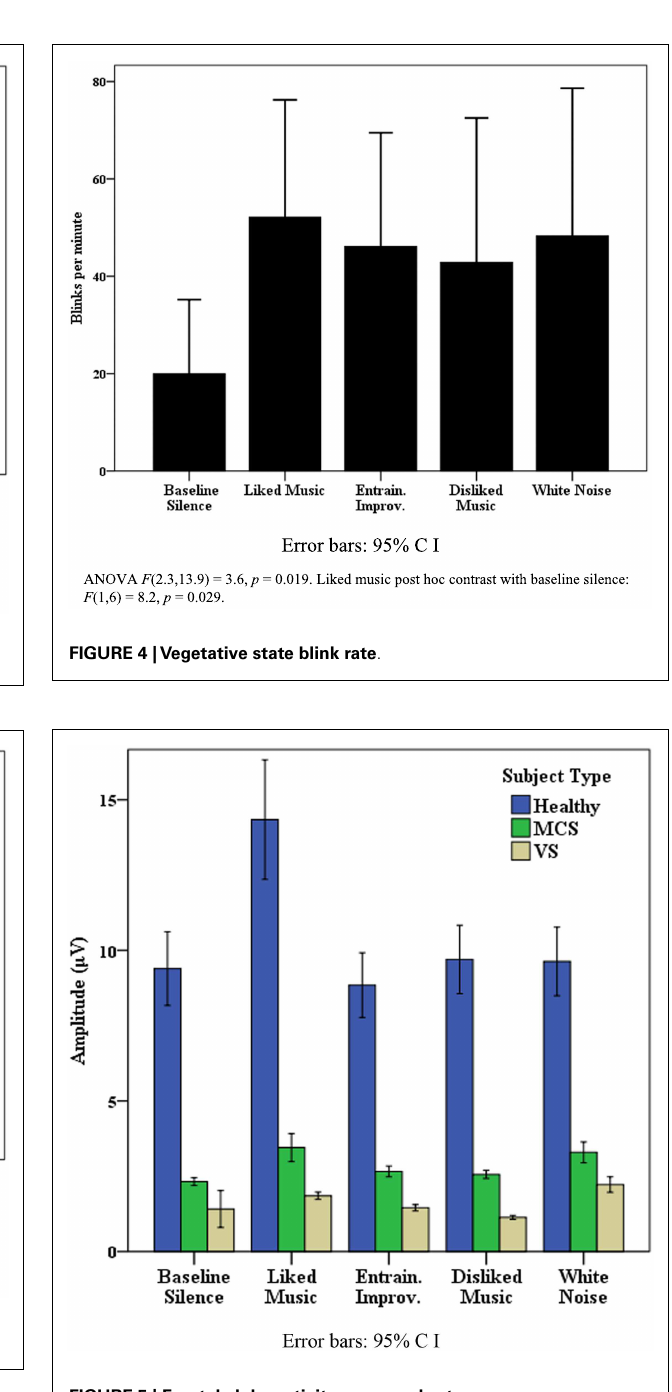
FIGURE 5 | Frontal alpha activity across cohorts